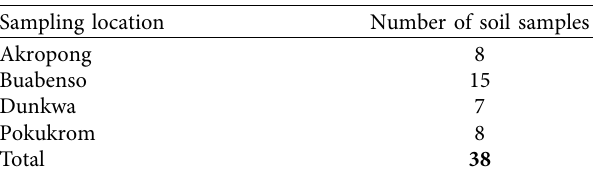
Table 2: Sampling locations and number of soil samples from the unmined study area.